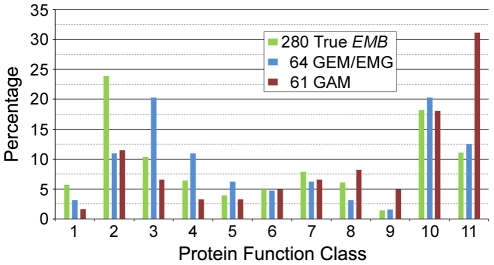
Distribution of protein function classes among different collections of essential genes.(1) DNA synthesis; repair; (2) RNA synthesis; modification; (3) protein synthesis; (4) Protein modification; transport; (5) protein degradation; (6) chromosome dynamics; (7) transcriptional regulation; (8) signaling pathways; (9) energy; electron transport; (10) metabolism; (11) cell structure; membrane function; trafficking. Significant differences are observed for function classes 2 (χ2 = 6.22; p<0.05), 3 (χ2 = 6.77; p<0.05), and 11 (χ2 = 16.7; p<0.001). Excluded are genes with functions that remain to be classified (15 “true” EMB; 5 EMG/GEM; 3 GAM) and those with uncertain or unknown functions (57 “true” EMB; 3 EMG/GEM; 6 GAM).